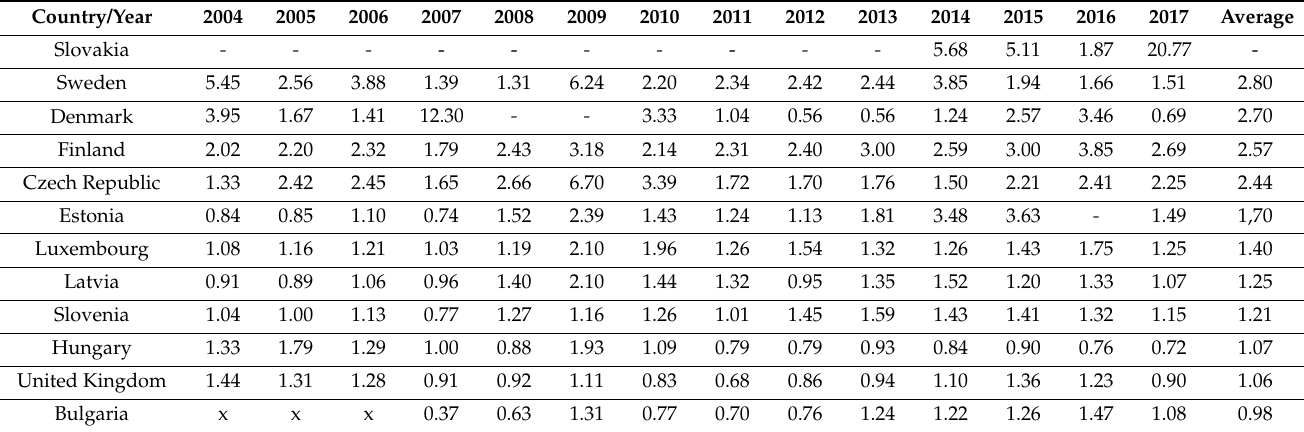
Table A2. The share of the balance of subsidies and taxes from investment and operating activities in regard to the income of a family farm in the EU countries in 2004–2017 (for Bulgaria and Romania years 2007–2017 and for Croatia years